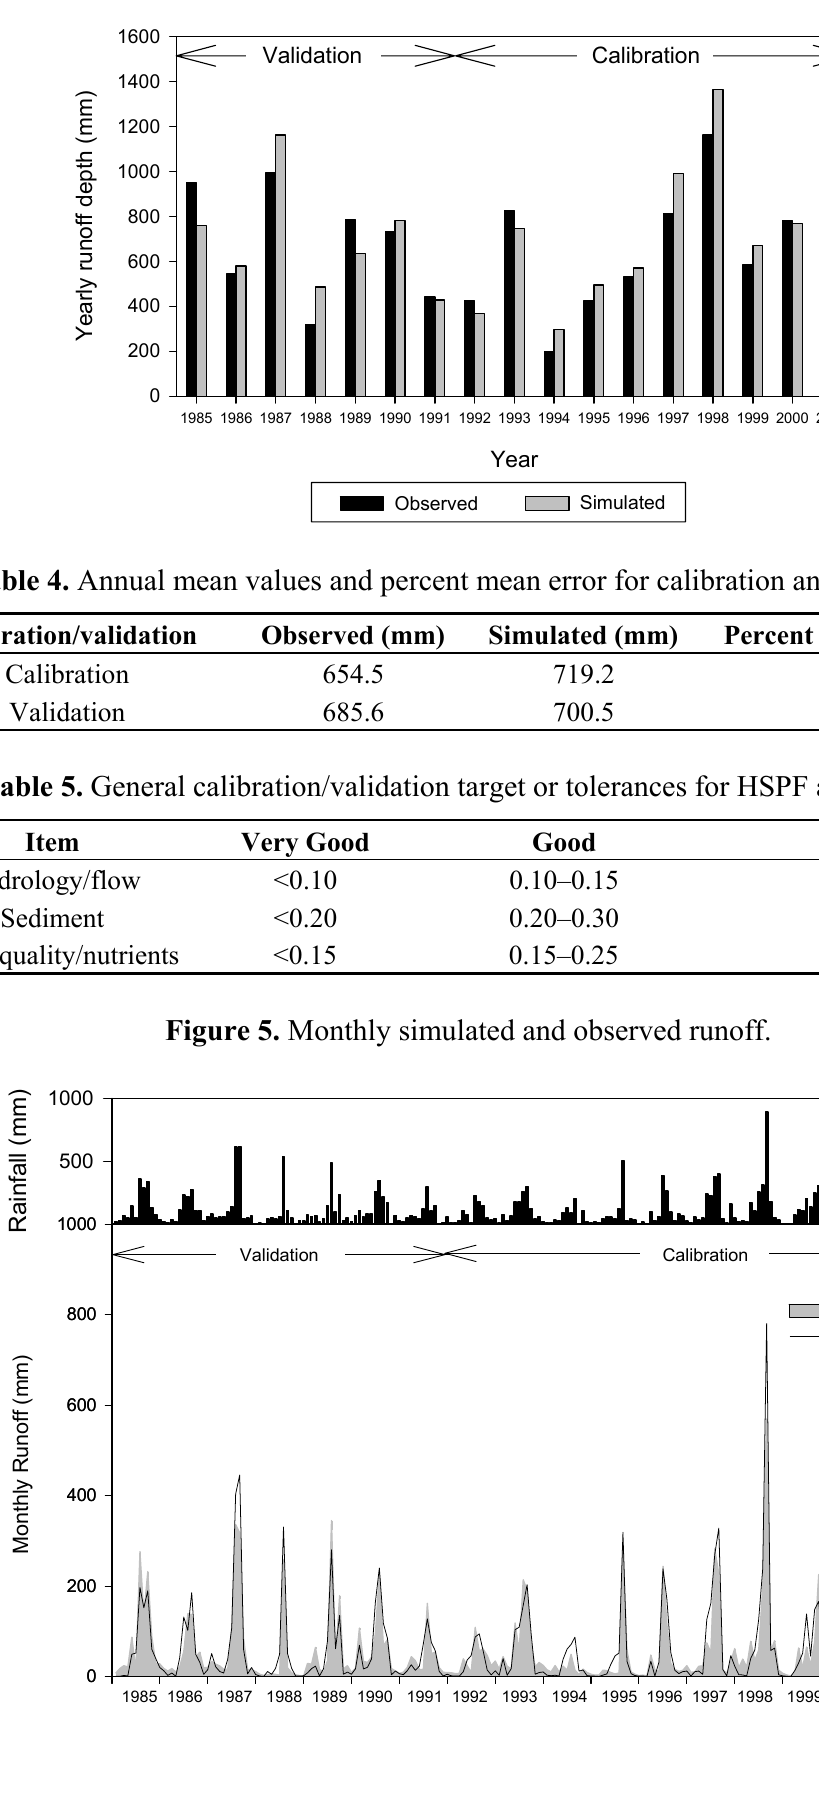
Figure 4. Comparison between observed and simulated yearly runoff.